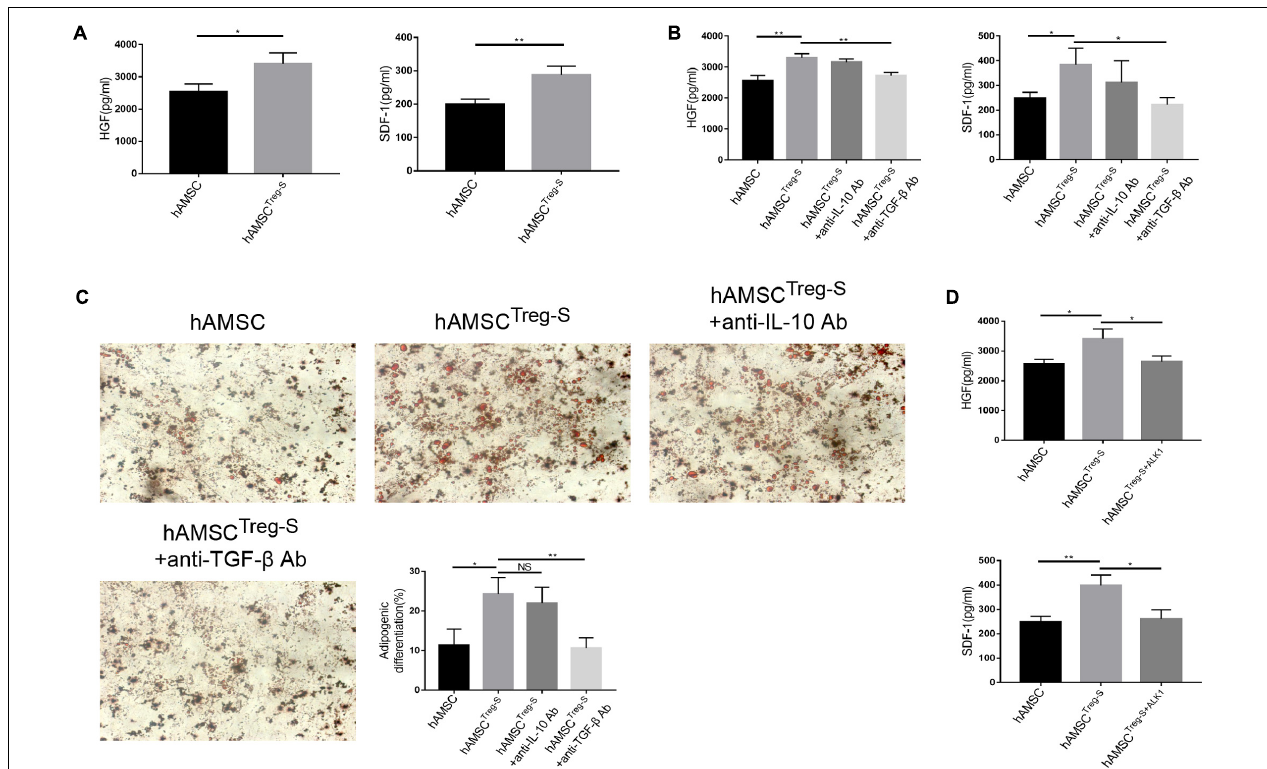
FIGURE 4 | hAMSC was treated with supernatant of Treg, anti-IL-10 Ab and anti-TGF- β Ab in vitro . (A) Level of HGF and SDF-1 of hAMSC and hAMSC Treg − S . (B) Level of HGF and SDF-1 in hAMSC, hAMSC Treg − S , hAMSC Treg − S with anti-IL-10 Ab and hAMSC Treg − S with anti-TGF- β Ab. (C) Representative images of hAMSC’s adipogenic differentiation in four groups. (D) Level of HGF and SDF-1 of hAMSC, hAMSC Treg − S , and hAMSC Treg − S with ALK1. The result is representative of three independent experiments. Data were mean ± SD of three independent experiments. * p < 0.05, ** p <